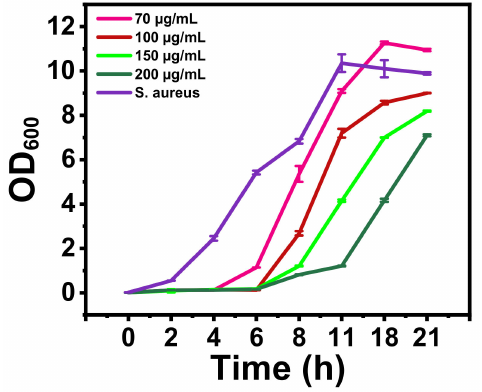
Figure 5. The effect of rGO-S/Se NPs on the growth of S. aureus in TSB containing various concentra- tions of NPs (70 µ g/mL, 100 µ g/mL, 150 µ g/mL, 200 µ g/mL, and S. aureus without NPs as control) grown at 37 ◦ C with shaking. The growth curve was determined by measuring the OD 600 nm of the sample versus time (h). Error bar represents standard error of mean.